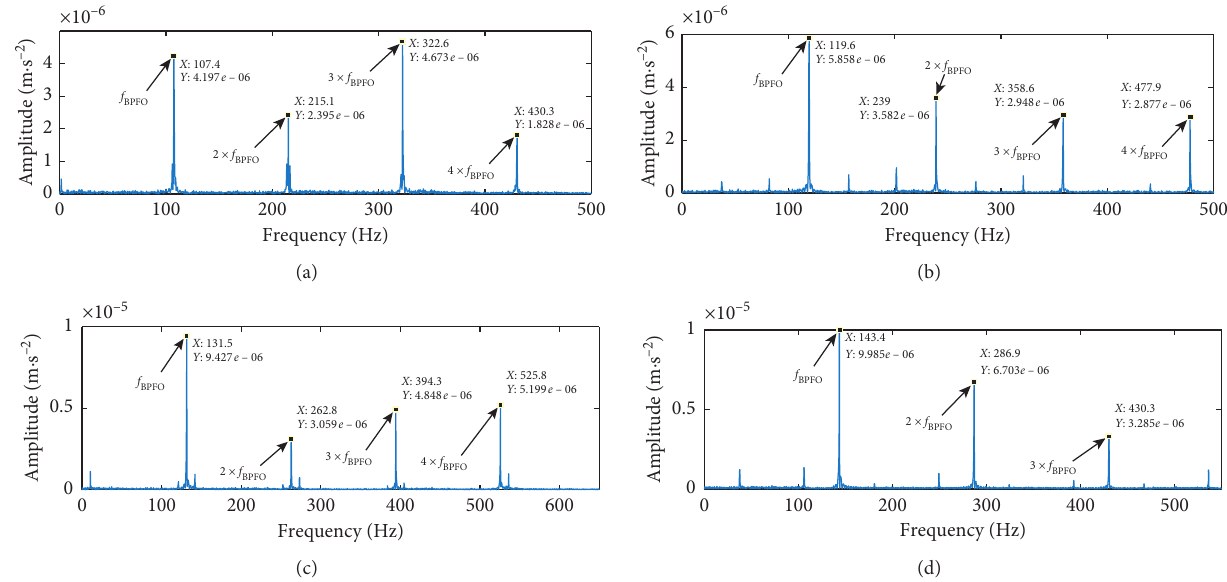
f ≠ 0N, and defect size